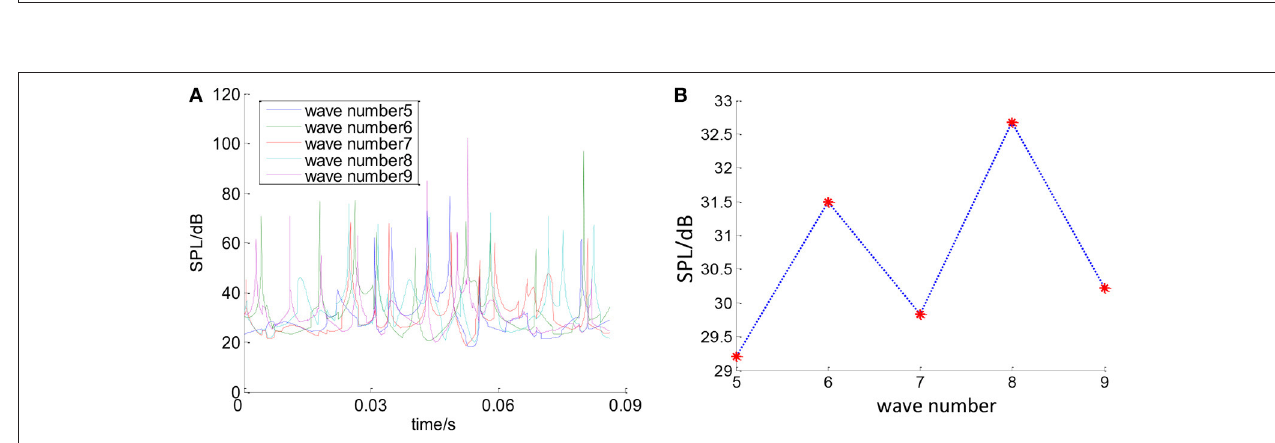
FIGURE 16 | Effect of wave number on bearing noise. (A) Effect of wave number on bearing SPL. (B) Effect of wave number on average bearing SPL.